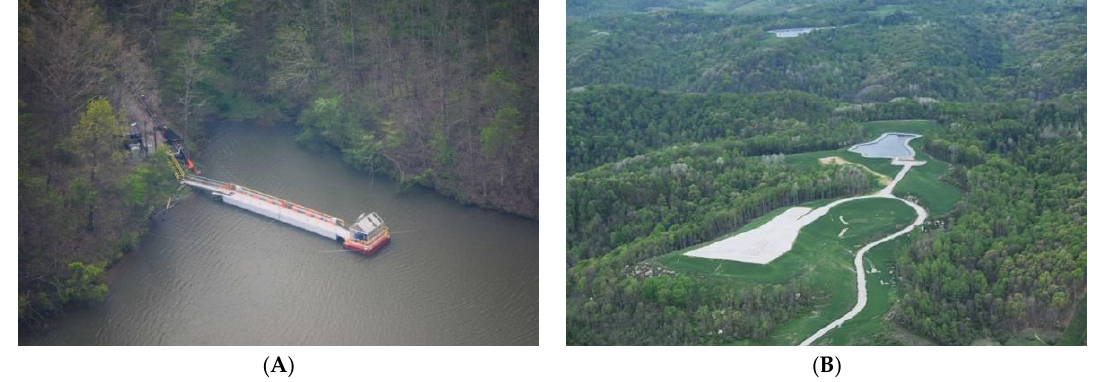
Figure 9. Typical unconventional oil and gas development (UOGD) freshwater infrastructure in south-east Ohio: Antero’s Barnesville Reservoir Pump ( A ); typical hydraulic fracturing well-pad and freshwater impoundment ( B ).